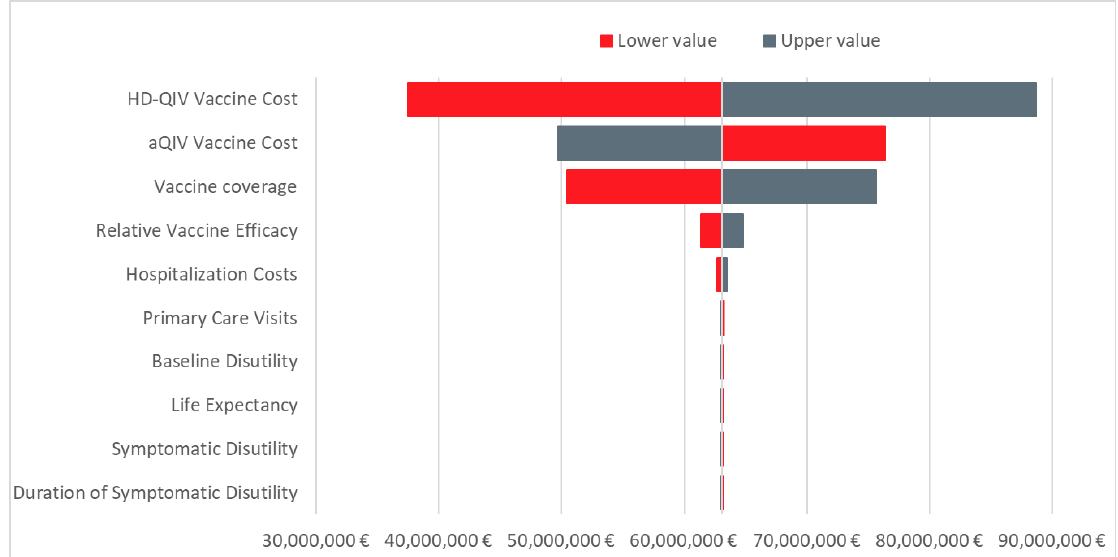
Figure 3. Tornado diagram showing the incremental net monetary benefit for aQIV vs. HD-QIV at a willingness-to-pay threshold of EUR 25,000 per QALY. Abbreviations: aQIV = adjuvanted QIV; HD-QIV = high-dose QIV.